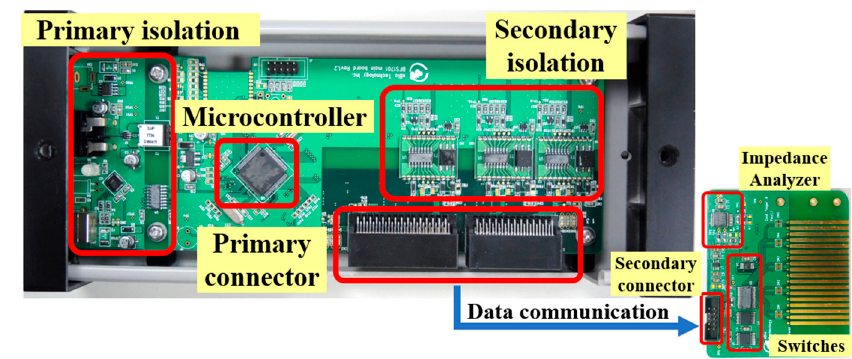
Figure 1. ( a ) Schematic plot and picture of the flexible pressure sensor. ( b ) Operation of the Kalman filter. ( c ) Block diagram. ( d ) Image of the developed impedance readout system.